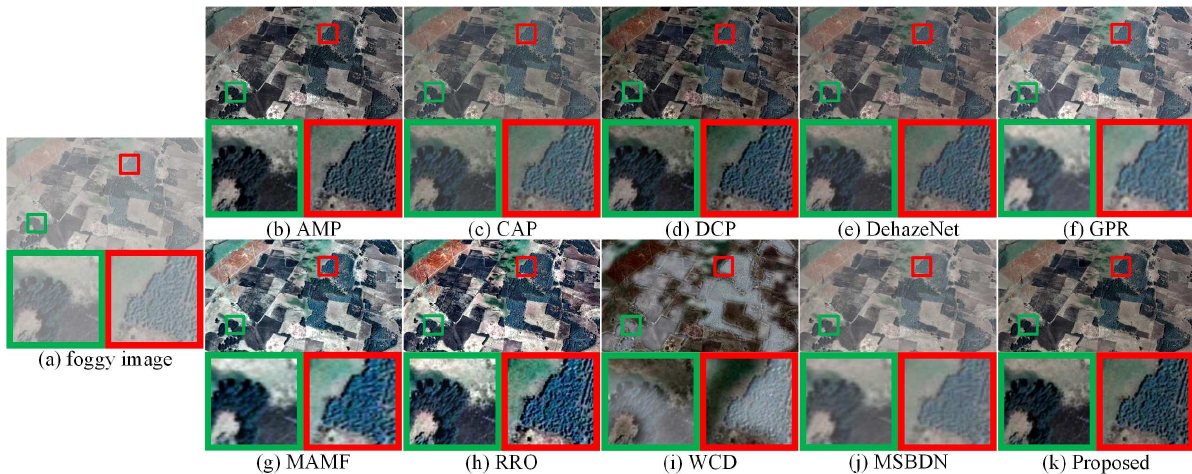
Figure 7. ( a ) shows a synthetic foggy remote sensing image. ( b – k ) respectively represent the defogged images obtained by AMP, CAP, DCP, DehazeNet, GPR, MAMF, RRO, WCD, MSBDN, and the proposed method. The two partially enlarged images marked in the green and red frames correspond to two areas enclosed by the green and red frames in each defogged